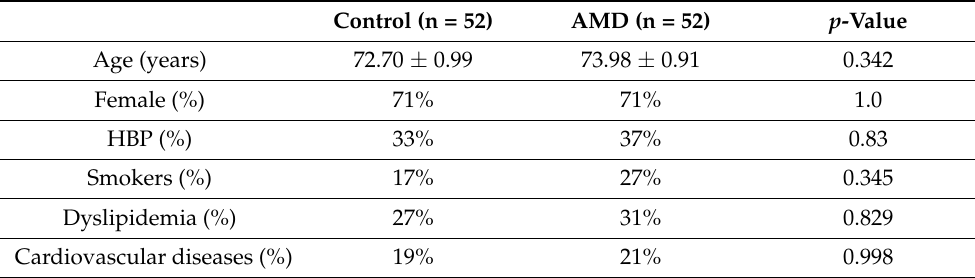
Table 1. Demographic data and clinical characteristics of participants.